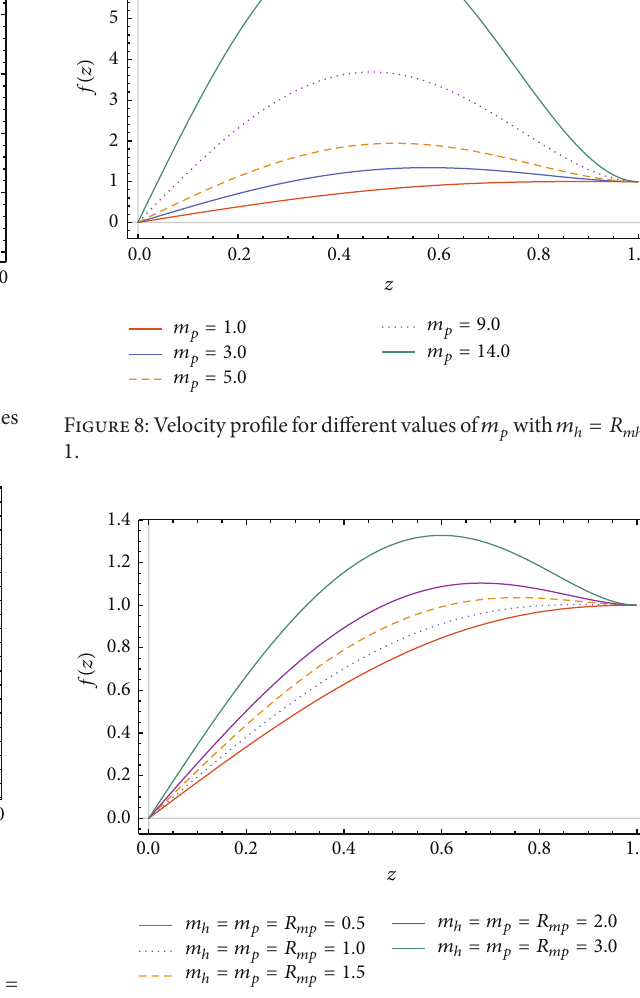
Figure 9: Velocity profile for equal values of 𝑚 𝑝 , 𝑚 ℎ , and 𝑅 𝑚𝑝